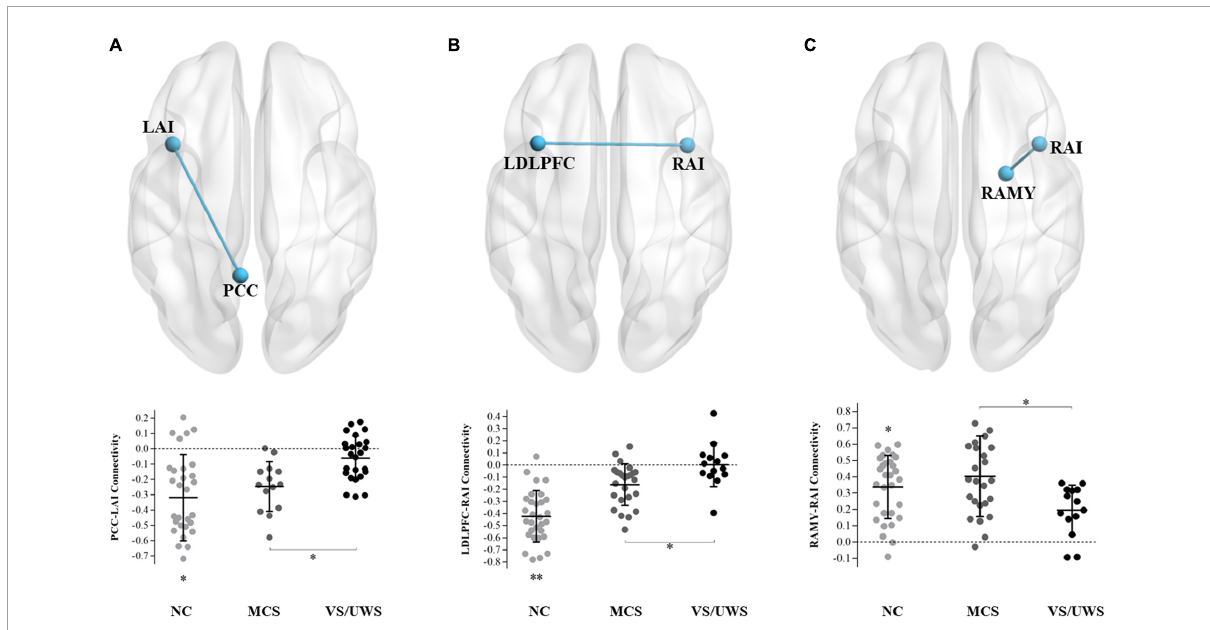
FIGURE1 Connectivity differences between MCS and VS/UWS patient groups and NC group in ROI-wise analyses. Between-group comparisons of the ROI-wise analyses indicated significantly decreased functional connectivity between PCC-LAI (A) , RAI-LDLPFC (B) , and RAI-RAMY (C) during rest, in the VS/UWS group relative to MCS and NC groups. The graphs illustrate the differences in functional connectivity of PCC-LAI, RAI-LDLPFC, and RAI-RAMY in MCS, VS/UWS patients and NC groups (AI, anterior insula; PCC, posterior cingulate cortex; DLPFC, dorsolateral prefrontal cortex; AMY, amygdala; L, left; R, right; NC, healthy control individuals; MCS, minimally conscious state; VS/UWS, vegetative-state/unresponsive wakefulness syndrome; ∗ p < 0.05; ∗∗ p < 0.01; error bars represent the standard error of